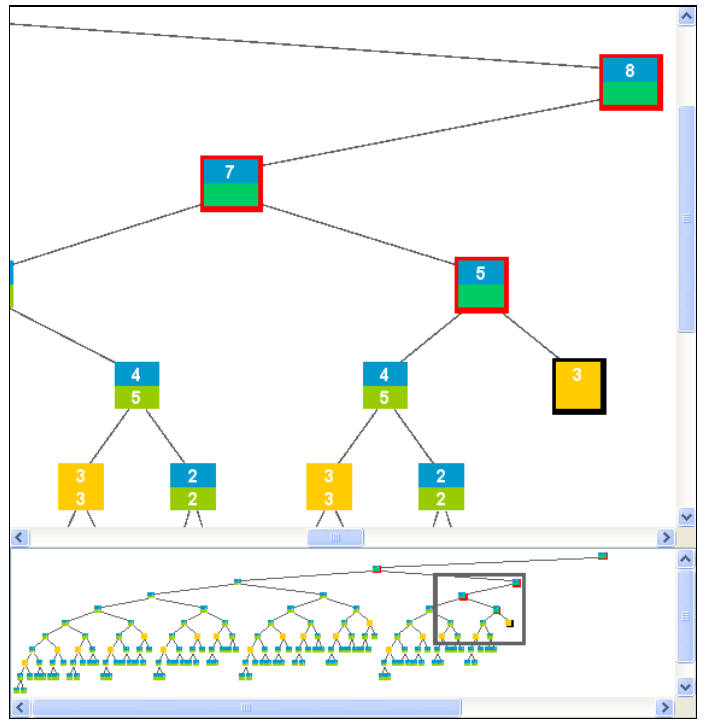
Figure 8. Recursion tree for fib (11) with the nodes corresponding to fib (3)